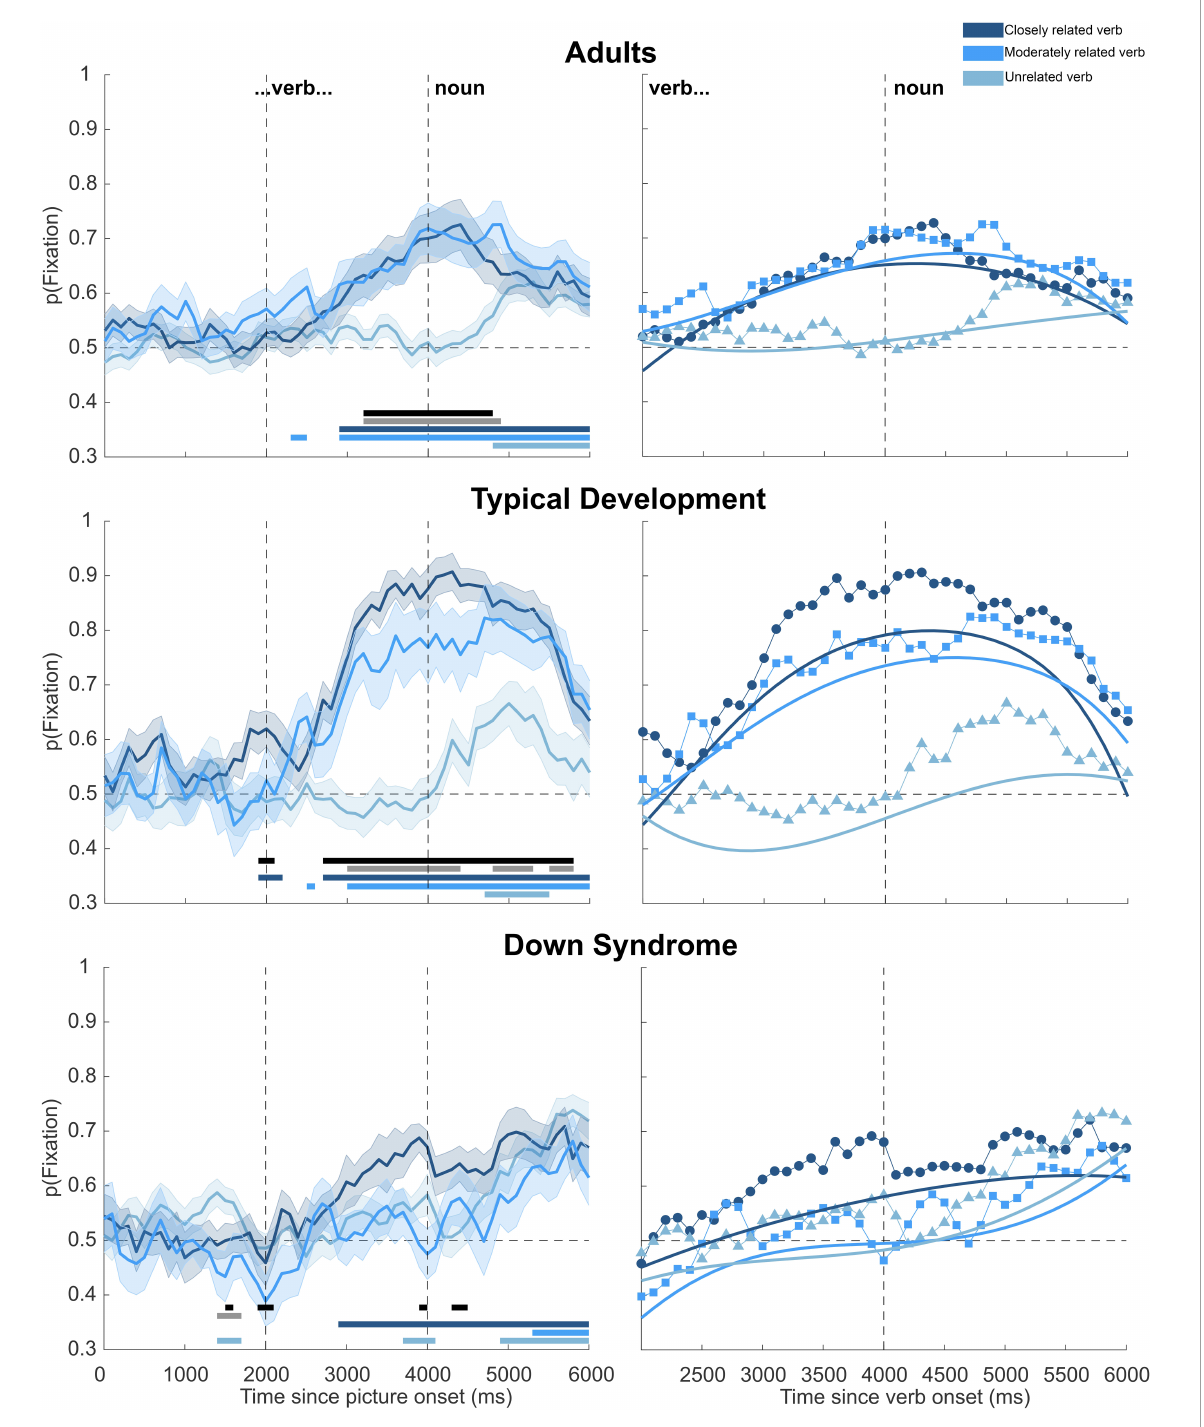
FIGURE2 Probability of fixation and fitted lines for all groups. Left panels lines represent the average probability of fixation. Shaded areas show standard error. The horizontal dashed line indicates chance level; the vertical dashed lines the presentation of the verb and the noun. Horizontal bars in the lower part of each plot indicate the significant clusters. Closely related and unrelated verb differences are shown in black, and moderately related and unrelated verb differences are shown in gray. Blue lines represent the difference with chance level (0.5), and the colored lines correspond to the colors of the conditions. Right panels lines with markers show the average probability of fixation. Solid lines indicate the fitted line from the growth curve analysis. The horizontal dashed line shows the chance level, and the vertical dashed line the presentation of the noun. Note that the time shown in this plot begins with the presentation of the verb. The image used a creative commons zero (cc0) license and it is the image of public